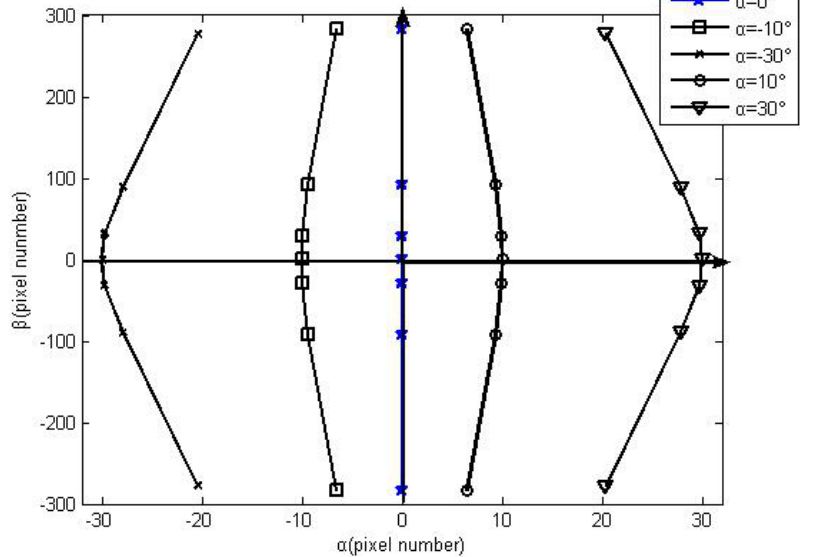
Figure 3. The trend of coordinate shift. In order to highlight the shift trend of the x coordinate, the x coordinate values translate towards the origin alone the x